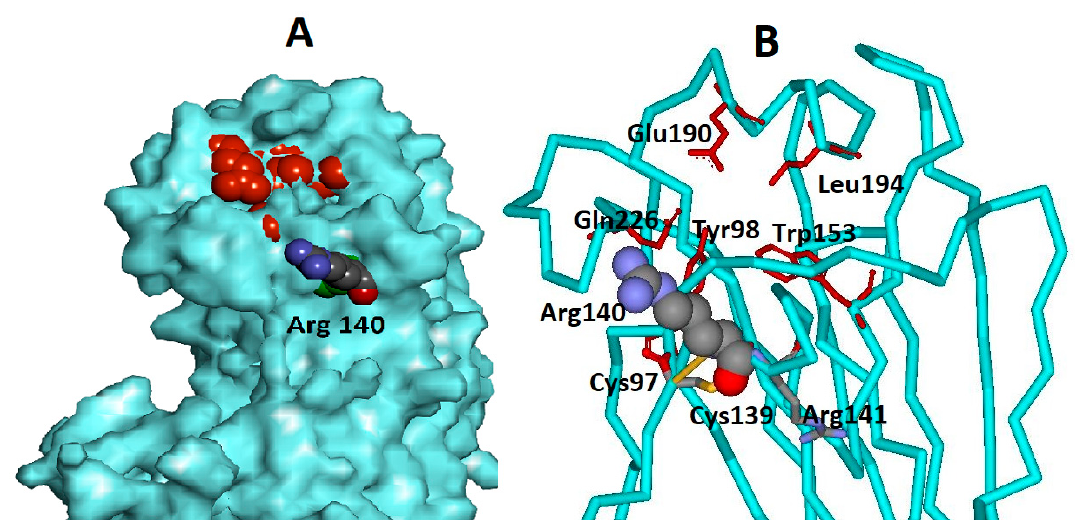
Figure 1. Arg140 arrangement in HA. Atomic coordinates of H7 HA (1ti8) were used [24]. ( A ) The protein surface is colored blue. The key amino acids of RBS are colored red. The Arg140 is colored by element. ( B ) Protein chain of HA near the RBS. The key amino acids of RBS are colored red and marked. The Arg140 and neighboring amino acids are colored by element.